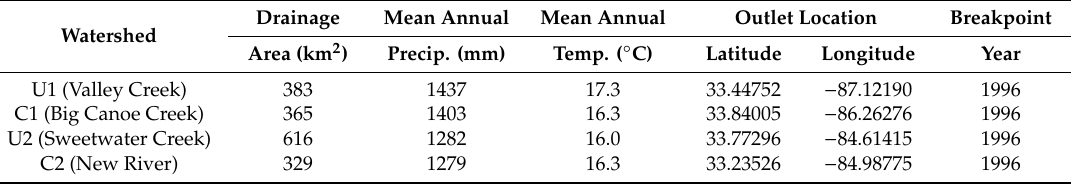
Table 1. Study watershed characteristics including the location of the outlet gauging station and the year that was determined as the breakpoint between the before and after urbanization